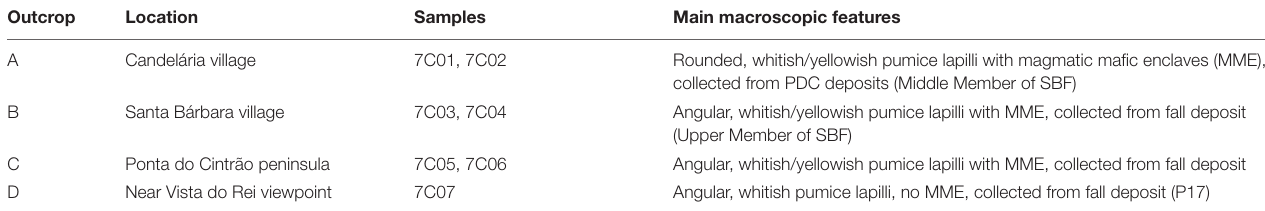
TABLE 1 | Overview of the samples used in this